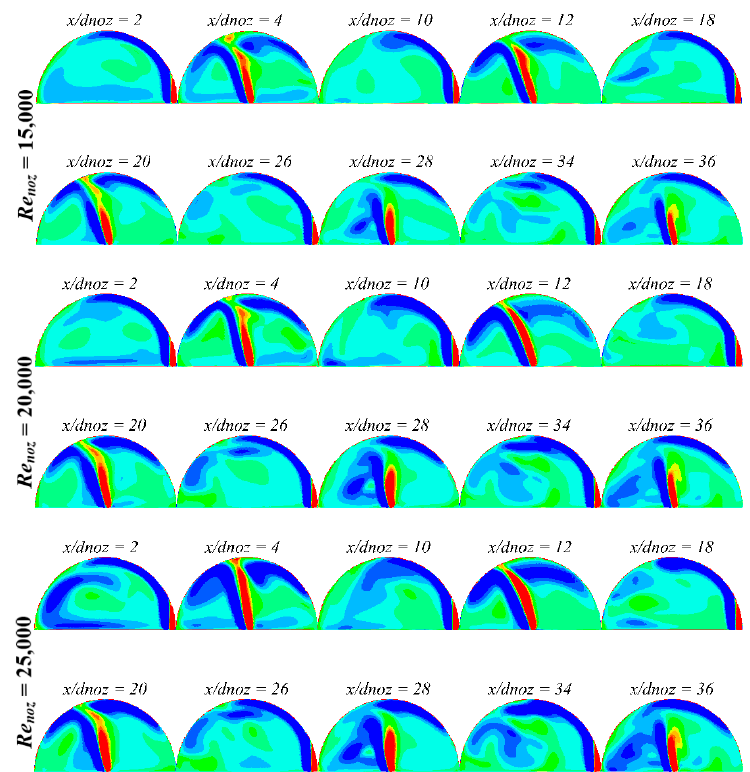
Figure 11. Axial vorticity contours of the compound cooling unit at different x/d noz sections.